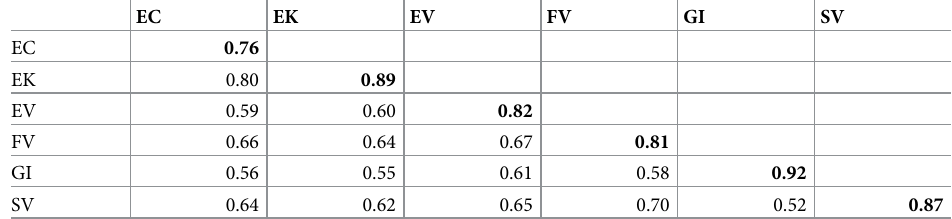
Table 4. Discriminant validity (Fornell-Larcker